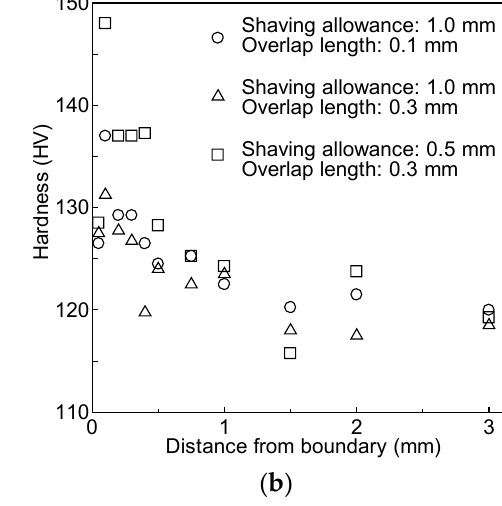
Figure 18. Distribution of Vickers’ hardness HV: ( a ) C1100; ( b ) A6061. The strain distributions along the central line of the tensile specimen are shown in Figure 19, which were measured at the maximum load point using a digital image corre- lation (DIC) measurement system (GOM correlate V8 SR1, GOM, Germany). The thick- ness strain was calculated using the measured longitudinal and transverse strains by as- suming a constant volume. The strain of A6061 is not exactly zero, but near zero, in both cases. It includes the measurement error to some extent. On the other hand, the strain of C1100 increases as the measurement point moves away from the boundary. The error is relatively larger in the thickness strain, because the error in the plane directions is accu- mulated. However, the trend is plausible, and the strain change through the boundary is smooth.